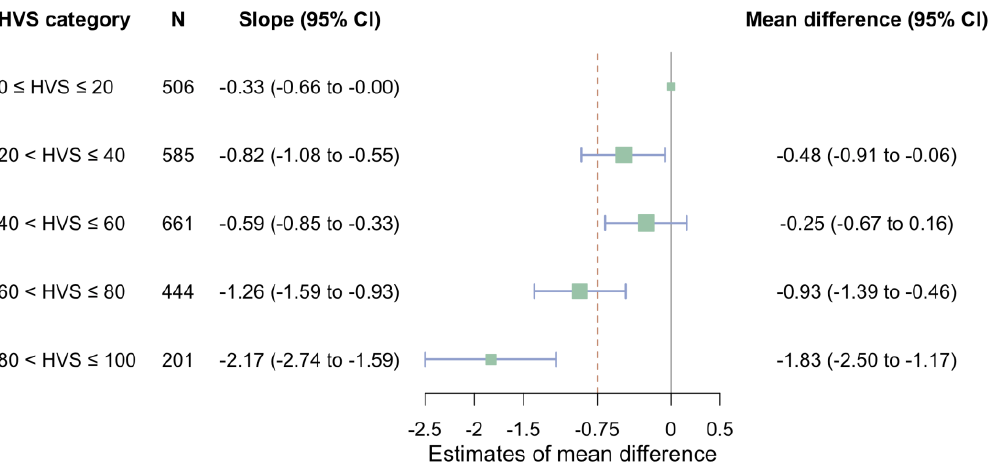
6 of 12 Figure 2. Odds ratio of HVS categories for experiencing a rapid eGFR annual decline. Abbrevia- tions: HVS, glycated haemoglobin A1c variability score; eGFR, estimated glomerular filtration rate; CI, confidence interval. A rapid eGFR annual decline is defined as eGFR annual decline at 5 mL/min/1.73 m 2 /year or more on average from baseline to end of follow-up. Compared with people with HVS ≤ 20% whose eGFR declined by 0.33 mL/min/1.73 m 2 per year on average, the eGFR declined by an extra 0.93 mL/min/1.73 m 2 (95% CI, 0.46 to 1.39; >MID) per year on average in people with the HVS between 60% and 80% and an